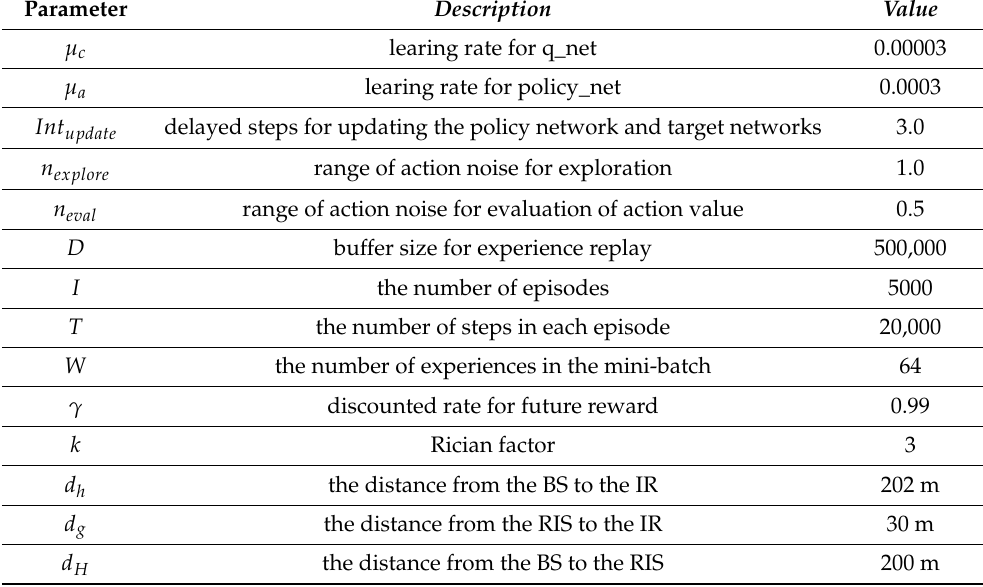
Table 1. Simulation